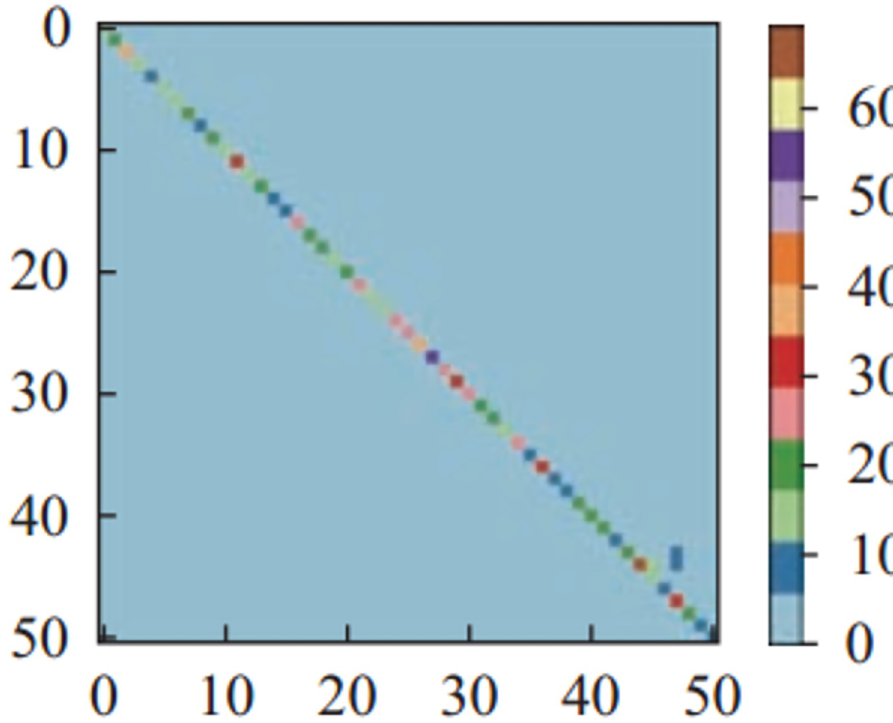
Fig 16. The confusion matrix of the first sectionalization in HMDB-51 under the input cropped image.